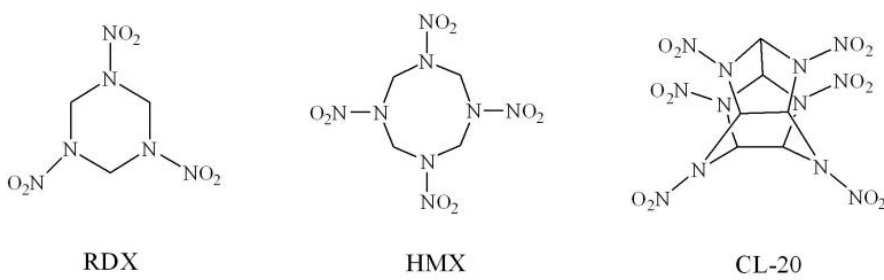
Figure 1. Molecular structures of RDX, HMX, and CL-20.